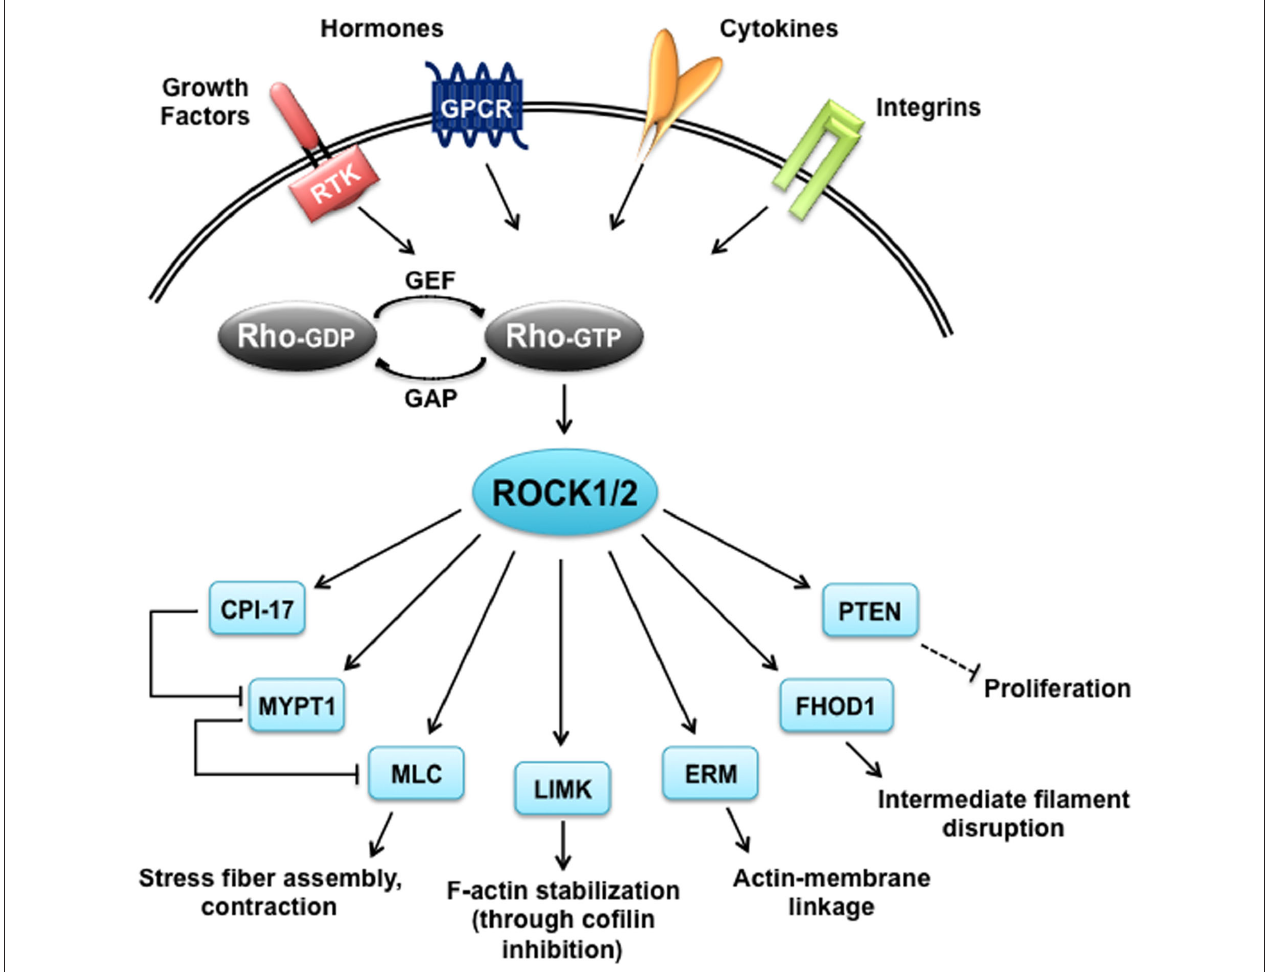
FIGURE 2 | ROCK targets. Rho proteins can be activated by guanine nucleotide exchange factors (GEFs), which are themselves activated by receptor tyrosine kinases (RTKs), G protein coupled receptors (GPCRs), cytokines and integrins. Rho-GTP subsequently activates ROCK1 and ROCK2 that have a broad range of substrates and are responsible for diverse cellular responses. CIP-17, kinase C-potentiated phosphatase inhibitor of 17 kDa; ERM, ezrin-radixin-moesin; FHOD1, formin homology 2 domain-containing 1; GAP, GTPase activating protein; LIMK, LIM-kinase; MLC, myosin II regulatory light chain; MYPT1, myosin phosphatase target subunit 1; PTEN, phosphatase and tensin homolog deleted on chromosome